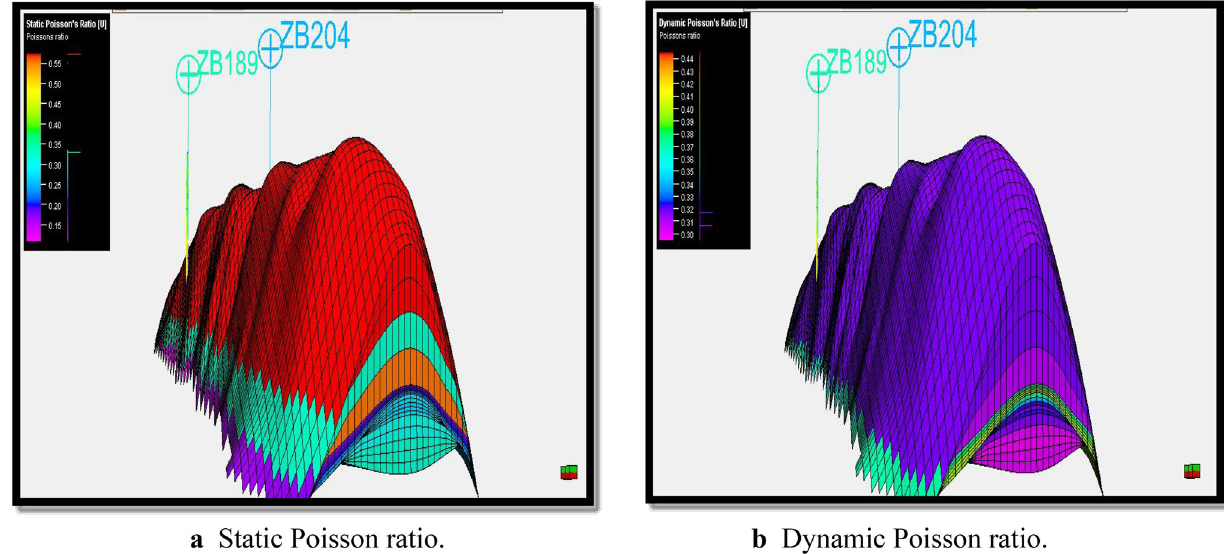
Fig. 17 Static and dynamic Poisson